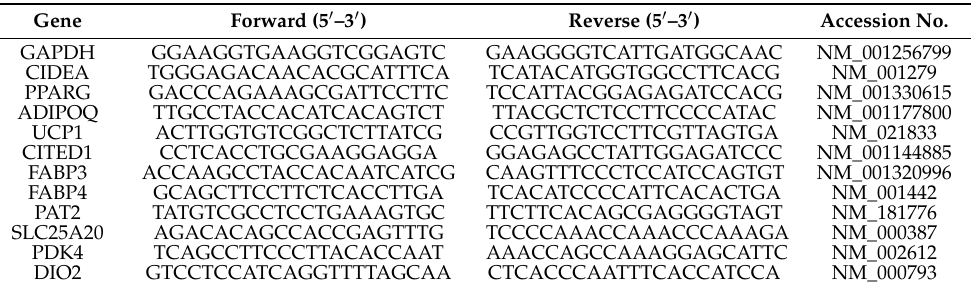
Table 1. List of primers used for